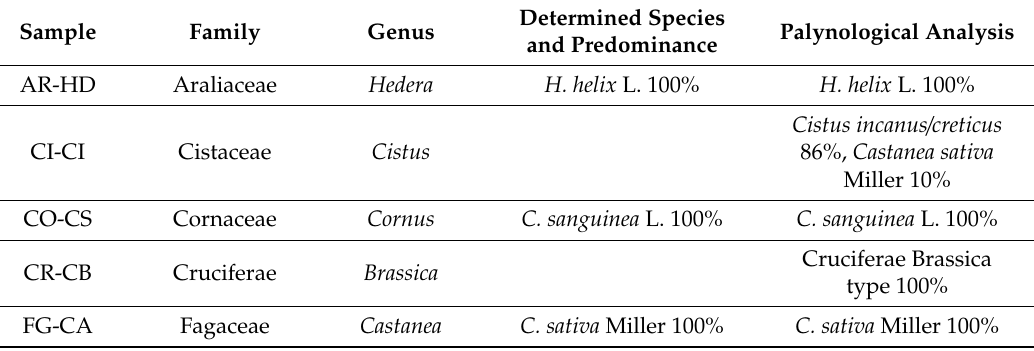
Figure 1. Bee pollen loads visual appearance. Samples were labelled with letters identifying the family and the genus as reported in Table 1. The segment represents 1 cm width. Table 1. Palynological characteristics of the bee pollen samples. Identification of pollen type, frequency, family and genus are provided. The botanical species was determined using the knowledge on territory’s flora, the cultivation maps and beekeepers’ indications.